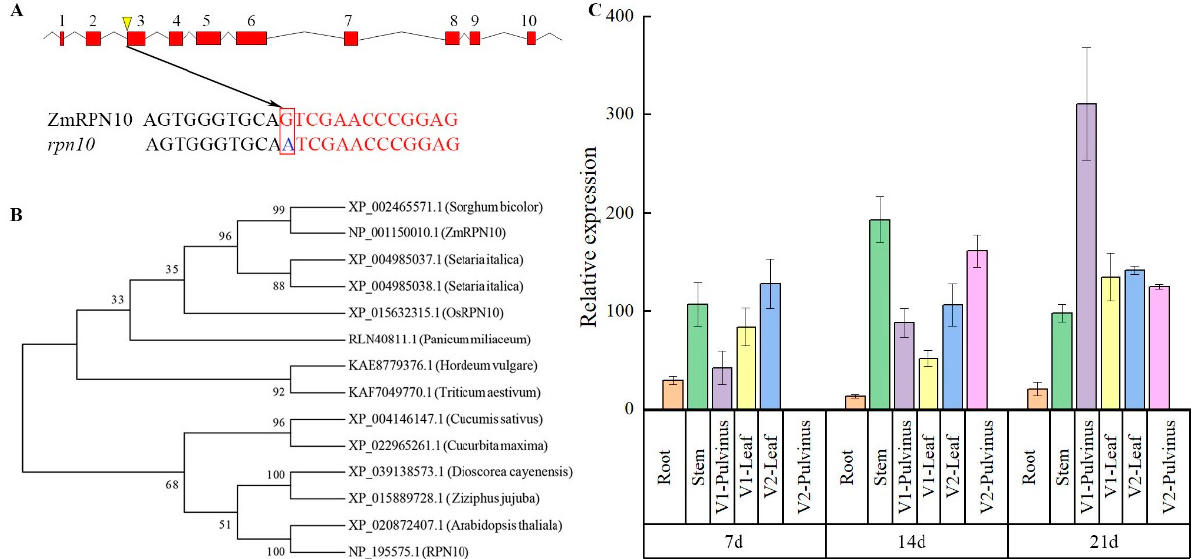
Figure 1. Analysis of ZmRPN10 in Maize. ( A ) Alignment of ZmRPN10 cDNA sequences in B73 and rpn10 ; ( B ) Phylogenetic tree of ZmRPN10; ( C ) Transcription expression of ZmRPN10 in different tissues of maize (V1: the first leaf in the seedling stage; V2: the second leaf in the seedling stage).